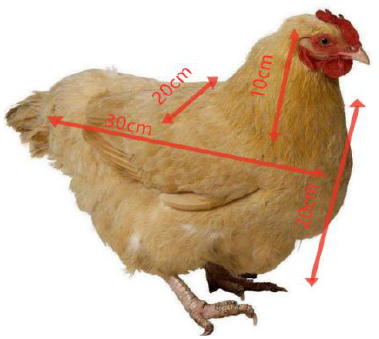
Figure 2. A diagram that shows the broiler sample used to measure and determine the model size.